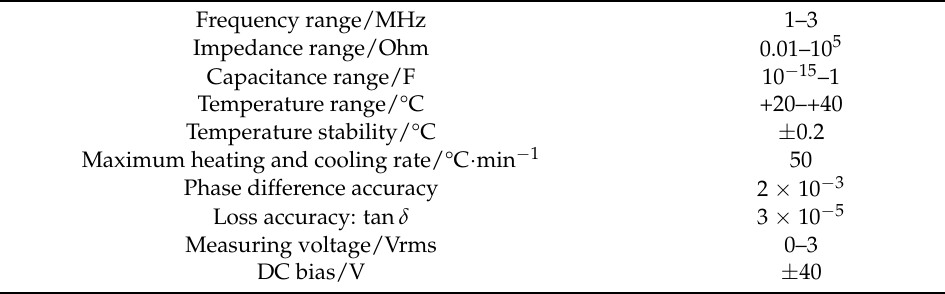
Figure 1. The schematic diagram of BDIS. Table 2. The technology parameters of the broadband dielectric and impedance